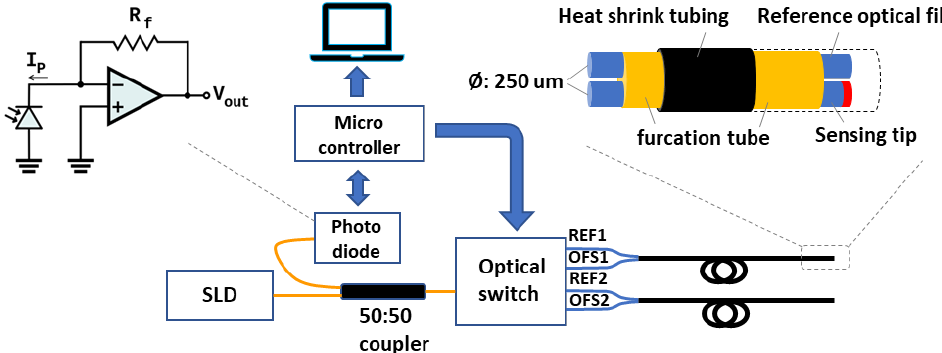
Figure 1. Humidity sensing system. Light is emitted from the light source and through an optical fibre coupler transmits to a port of the optical switch. The photodiode and transimpedance amplifier convert the reflected light intensity to a voltage which is then transferred to the pc via the microcontroller.